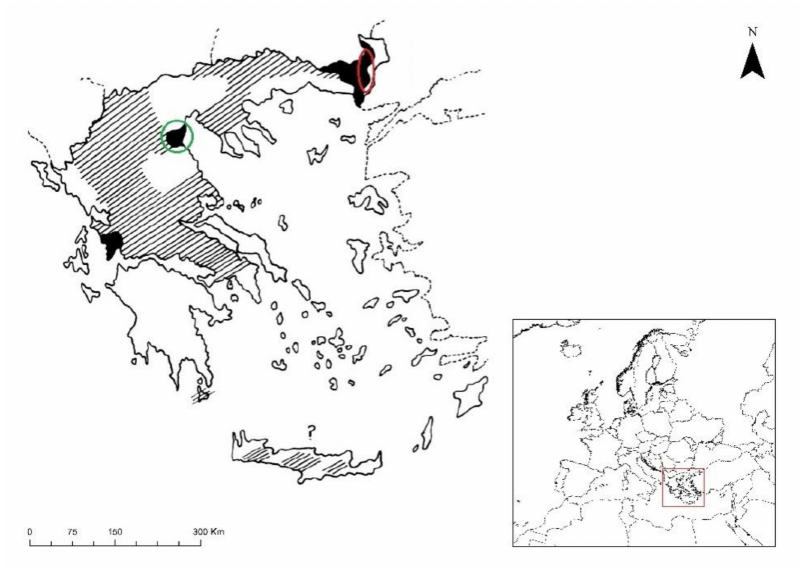
Figure 1. Historic and current distribution of the Eurasian Black Vulture ( Aegypius monachus ) in Greece, Southeast Europe (red square). Hatched areas show the distribution of the species in 1850, while solid black areas show the distribution in 1980. The red circle shows the current distribution of the species in the DLS-NP, while the green circle shows the Olympus National Park. The map is modified by